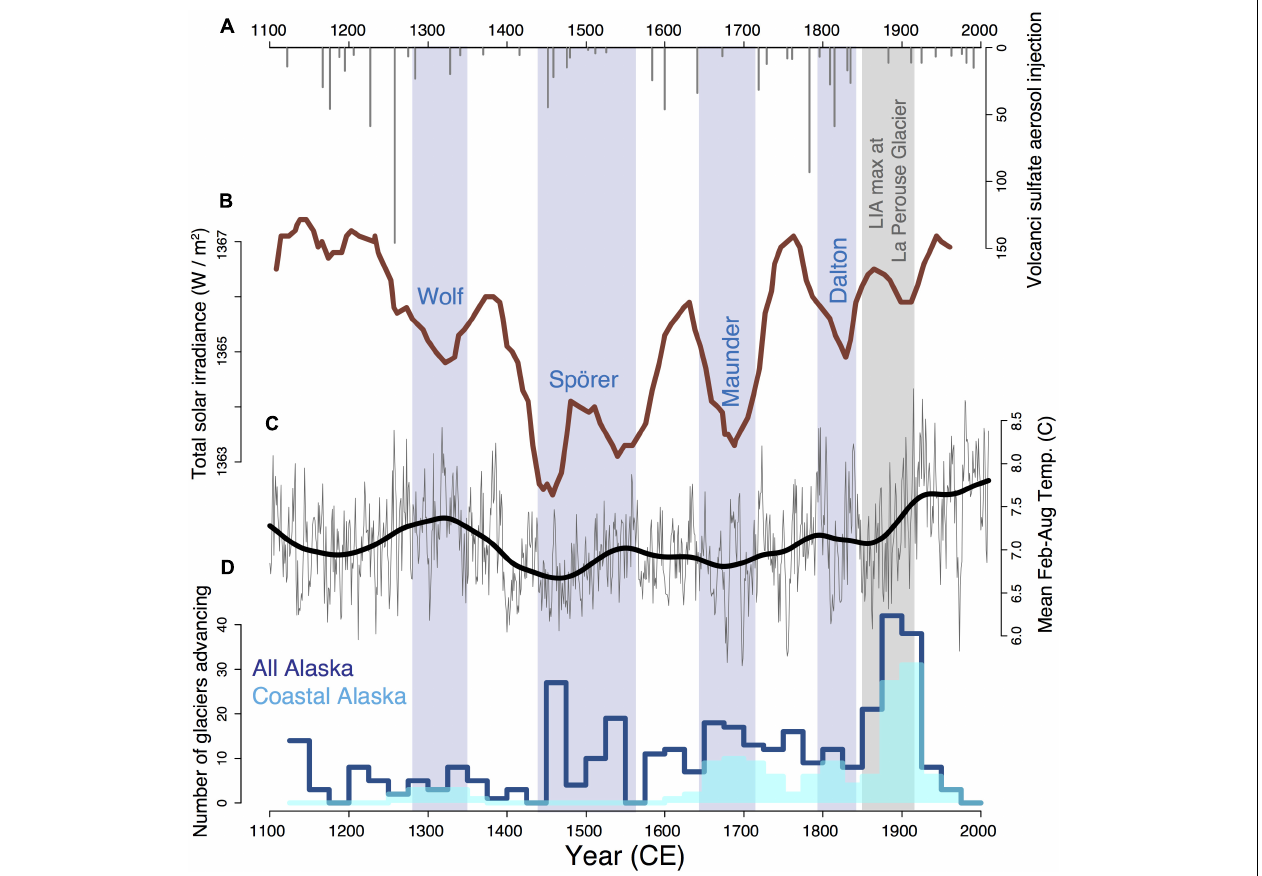
FIGURE 6 | Climate forcing agents, and regional paleoclimate records in the Gulf of Alaska region during the Little Ice Age (LIA). (A) Volcanic forcing (Gao et al., 2008). (B) Solar activity with solar minima labeled (Bard et al., 2000). (C) Reconstructed mean February to August temperature (Wiles et al., 2014). (D) LIA glacier moraine record for all of Alaska (dark blue) and south-coastal Alaska (turquoise) (Wiles et al., 2004) including the La Perouse Glacier’s maximum advance highlighted in gray. Note that most of the Coastal Alaska glaciers advanced shortly after the Dalton Minimum, which was relatively minor in terms of solar forcing and summertime